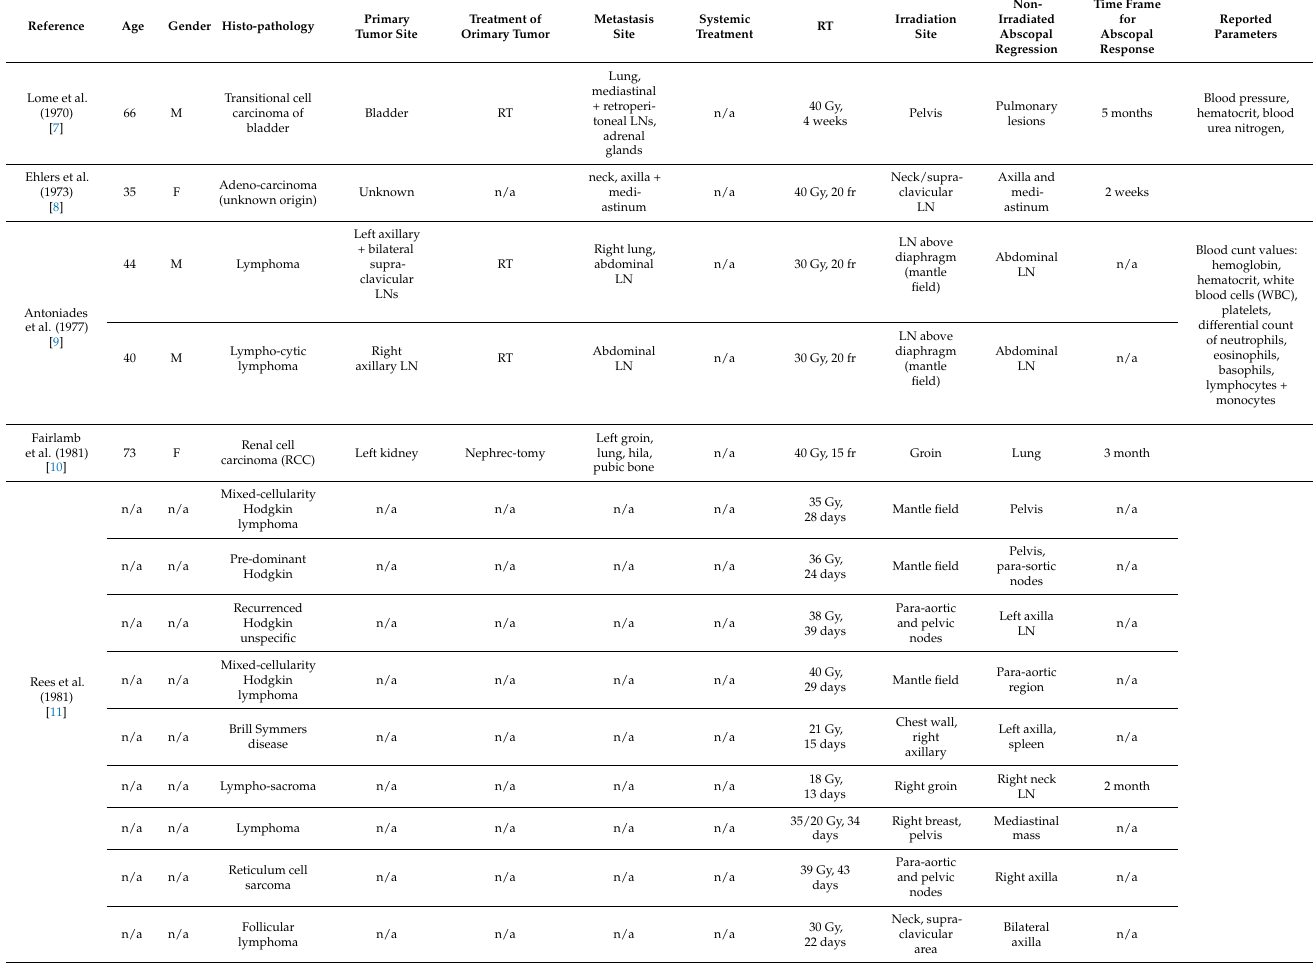
Table 1. Abscopal effect case reports (no